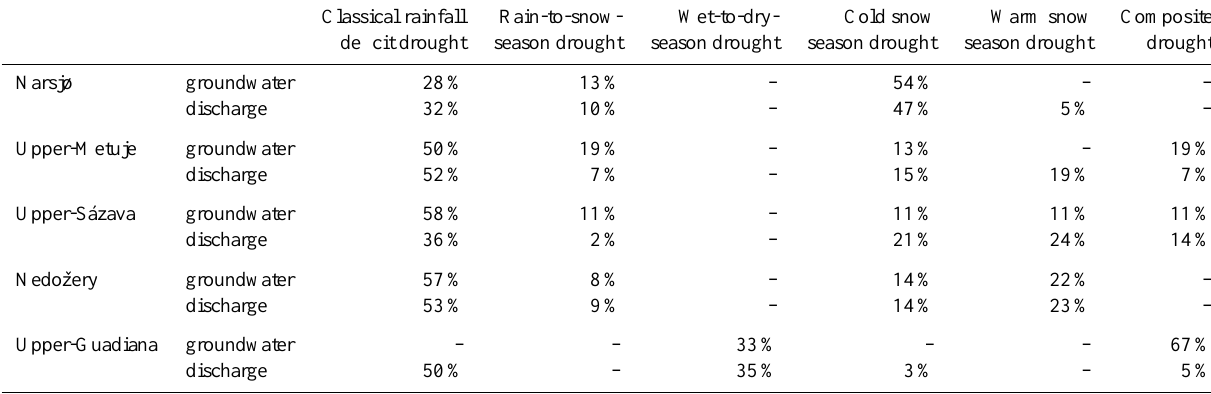
Table 4. Drought types of all drought events per catchment (groundwater and discharge).